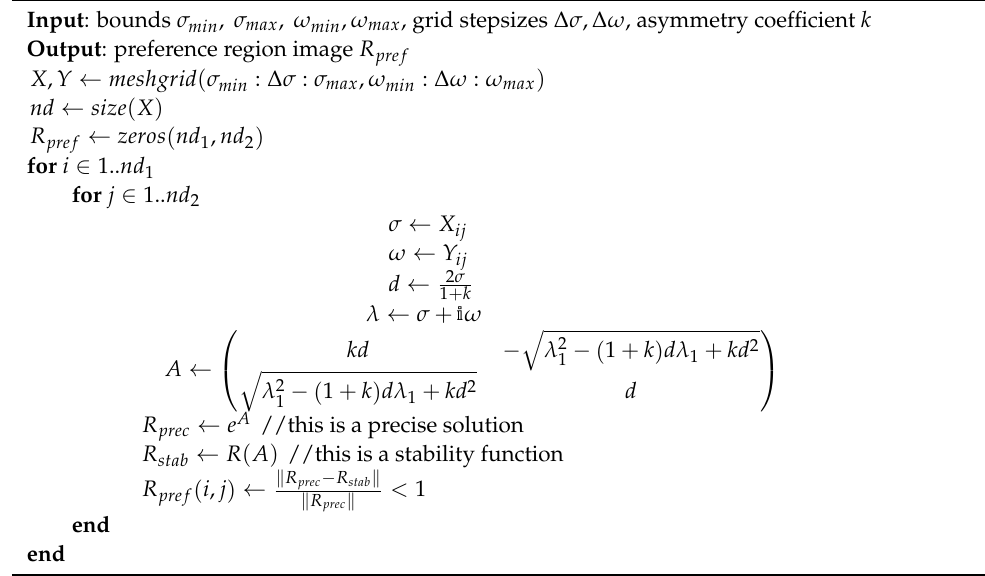
Algorithm 2: Plotting preference region for the multi-dimensional test problem